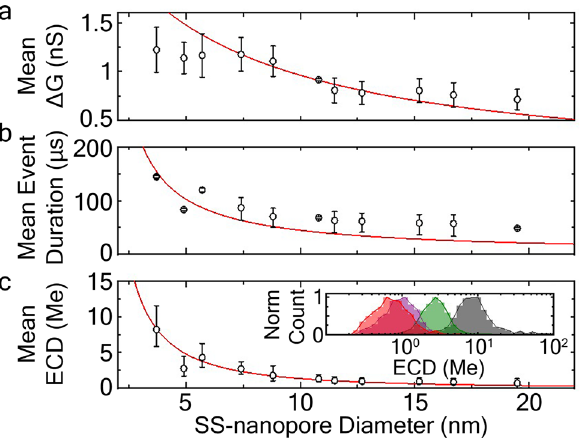
Figure 3. Effect of SS-nanopore diameter on mean event ( a ) conductance change, ( b ) duration, and ( c ) ECD values for 130 kDa quasi-monodisperse HA, at a concentration of 15 ng/μL. At least 1500 events were considered for each data point shown. Red lines are model fits to the data (see text for details). Error bars represent measurement standard deviation. Inset of ( c ) shows example normalized ECD histograms obtained from SS-nanopores with diameters (left to right) 19.5 (red), 12.9 (purple), 7.4 (green), and 3.7 nm